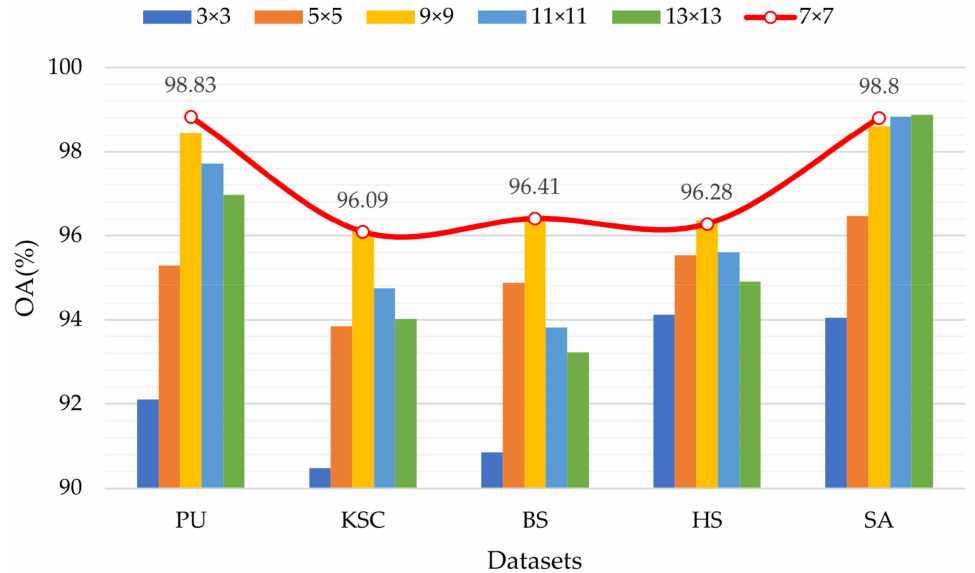
Figure 12. Comparison of OA using different spatial window sizes for the five